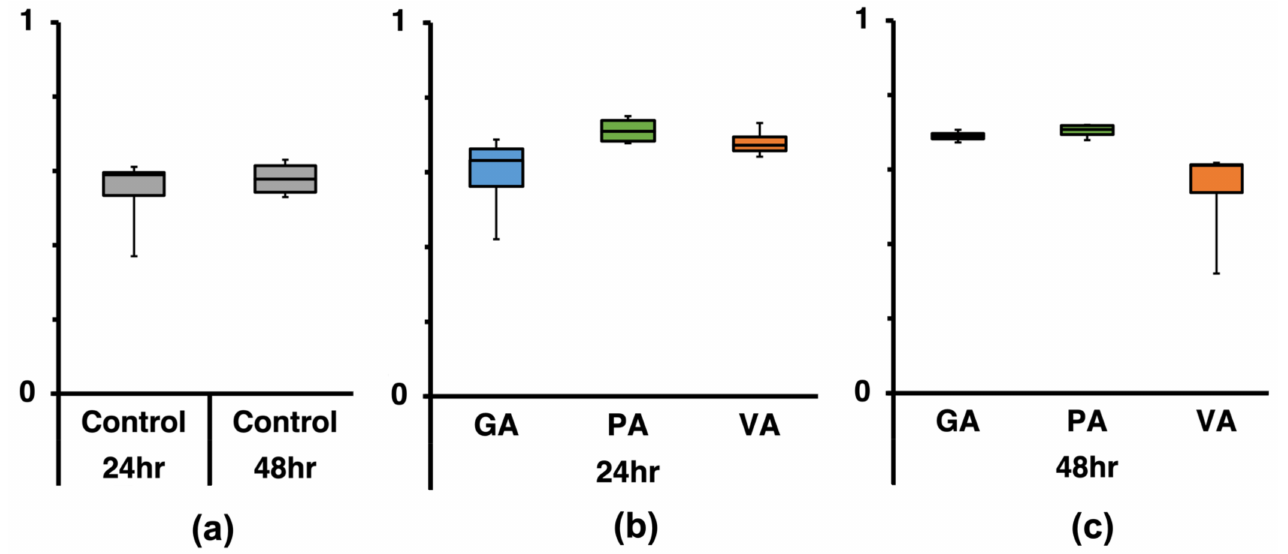
Figure 8. Beta diversity analysis at the species level using Sorenson’s Coefficient from 16S-rRNA gene sequencing data calculated by assessing overlap between the population of species found in untreated controls at 0 h with those at 24 h and 48 h ( a ) as well as assessing overlap between gallic acid (GA), protocatechuic acid (PA) and vanillic acid (VA) with their respective untreated control within the same timepoints, namely 24 h ( b ) and 48 h ( c